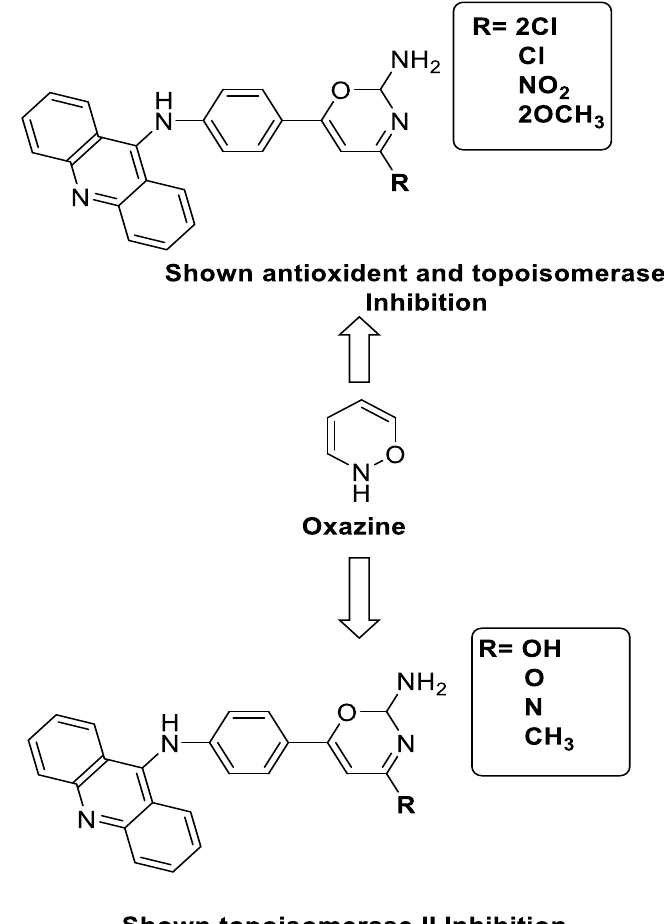
Figure 9. Oxazine as an antioxidant and topoisomerase II inhibitor.